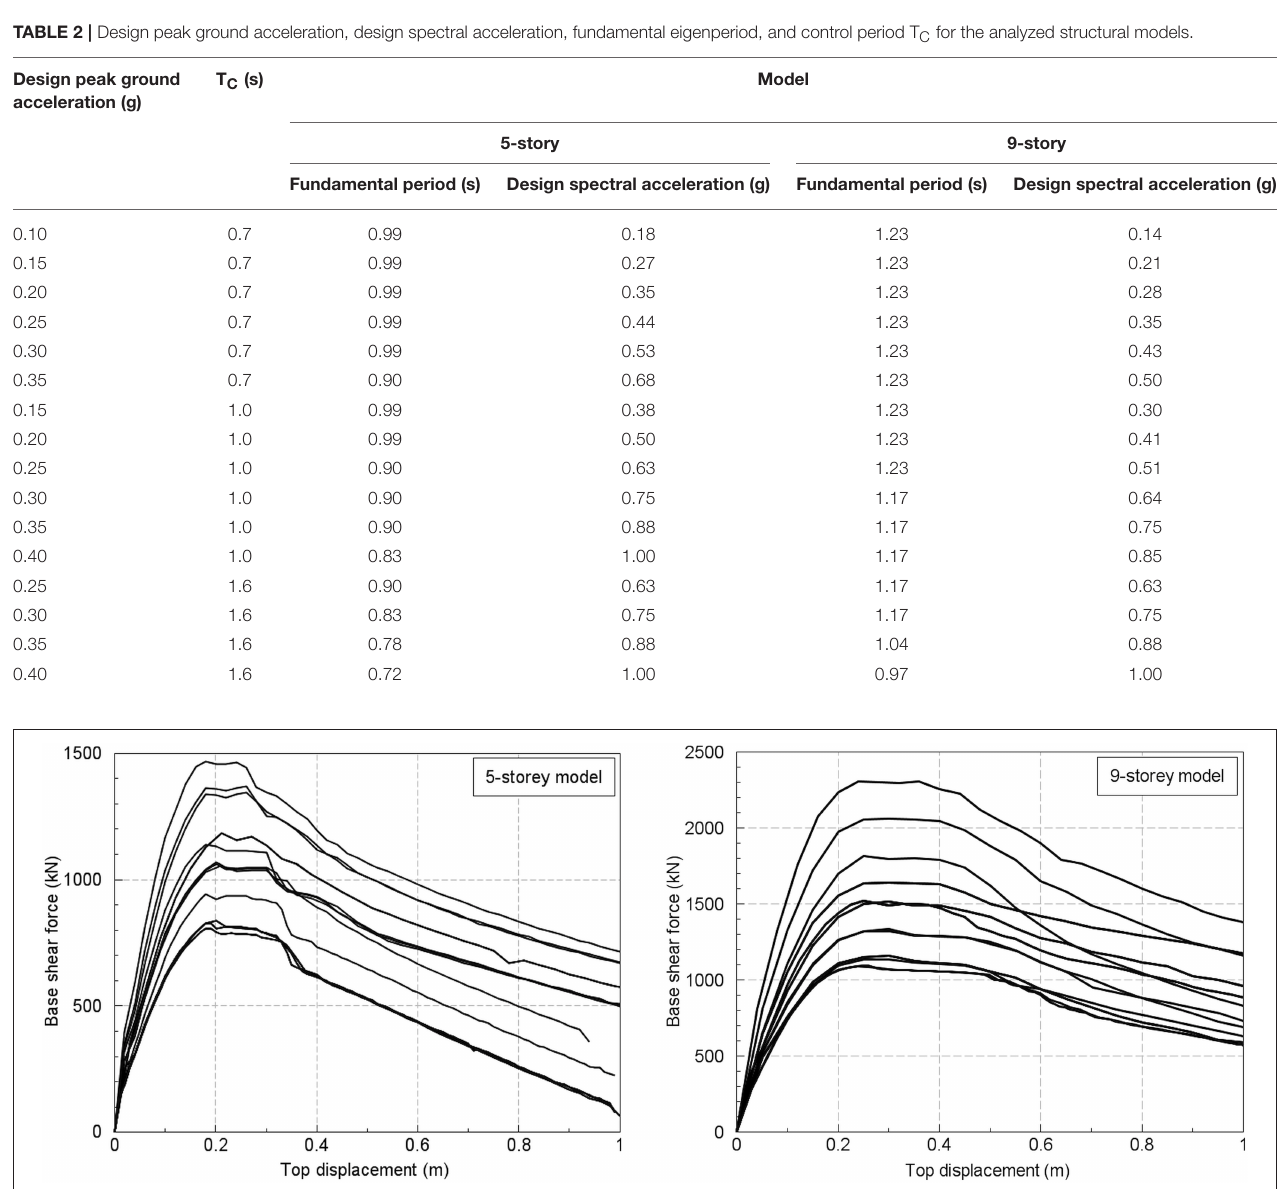
FIGURE 3 | Comparison of the pushover curves for the five-story model (Left) and nine-story model (Right)